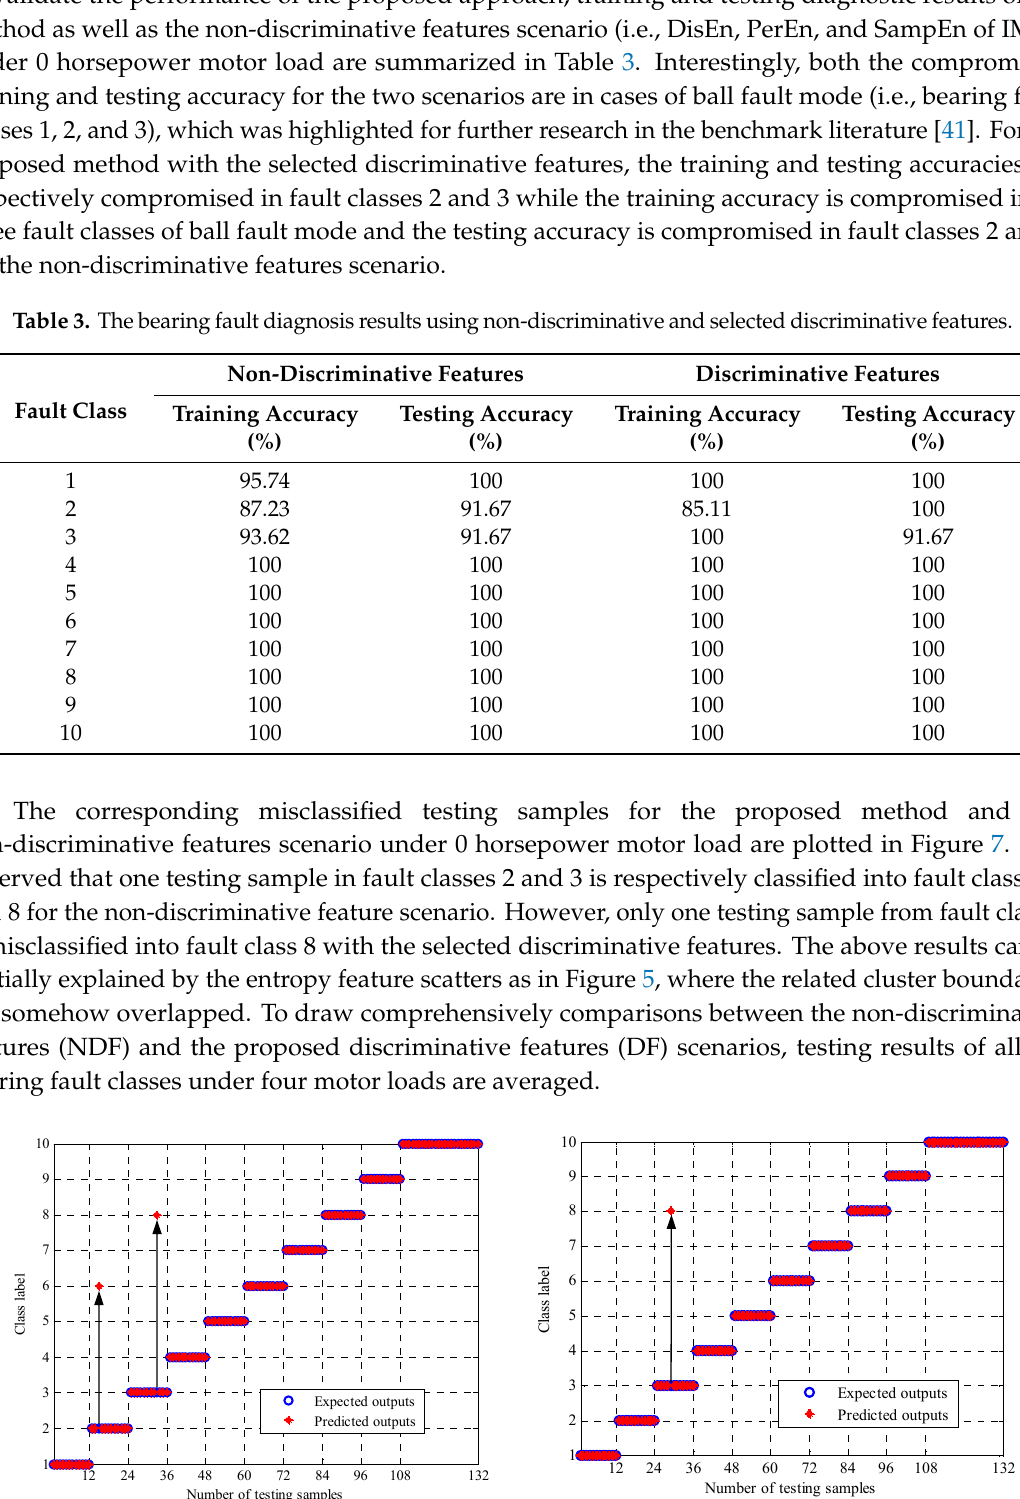
Table 3. The bearing fault diagnosis results using non-discriminative and selected discriminative features.